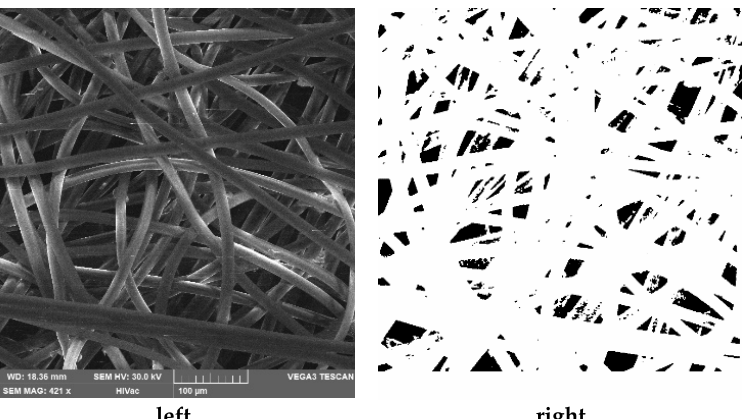
Figure 5. As an example, the image on the left reports the SEM image of the layer number one of the community 1 mask; on the bottom side of the image, the main parameters for the acquisition are indicated. On the right , the processed image in which the black areas indicate the void part of the tissue net.